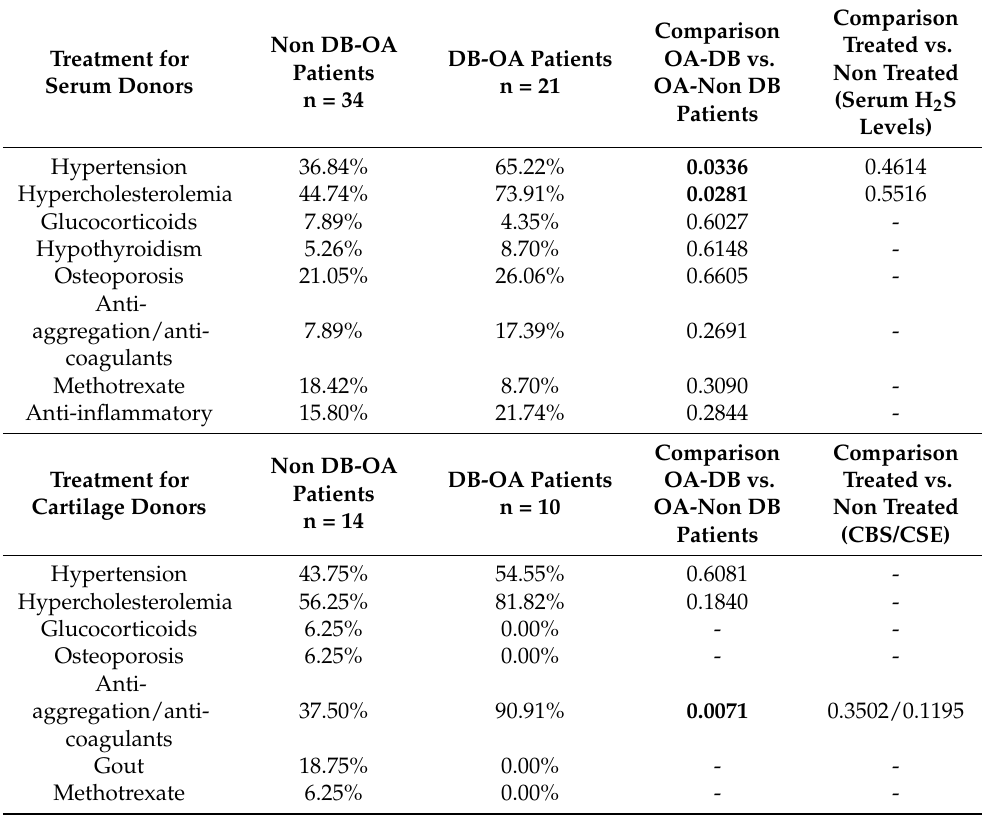
Table 4. Treatments received by donors of serum and cartilage samples. Second and third columns from the left show the percentage of the study population having each treatment. Second column on the right indicates p-value obtained in the statistical test for the comparison of percentage of individuals having each treatment between non DB-OA and DB-OA patients. First column on the right shows p-value obtained in the statistical test for a comparison of the means of serum H 2 S or CBS/CSE expression between the treated and not treated patients. p ≤ 0.05 shown in bold, analysed by the Mann–Whitney